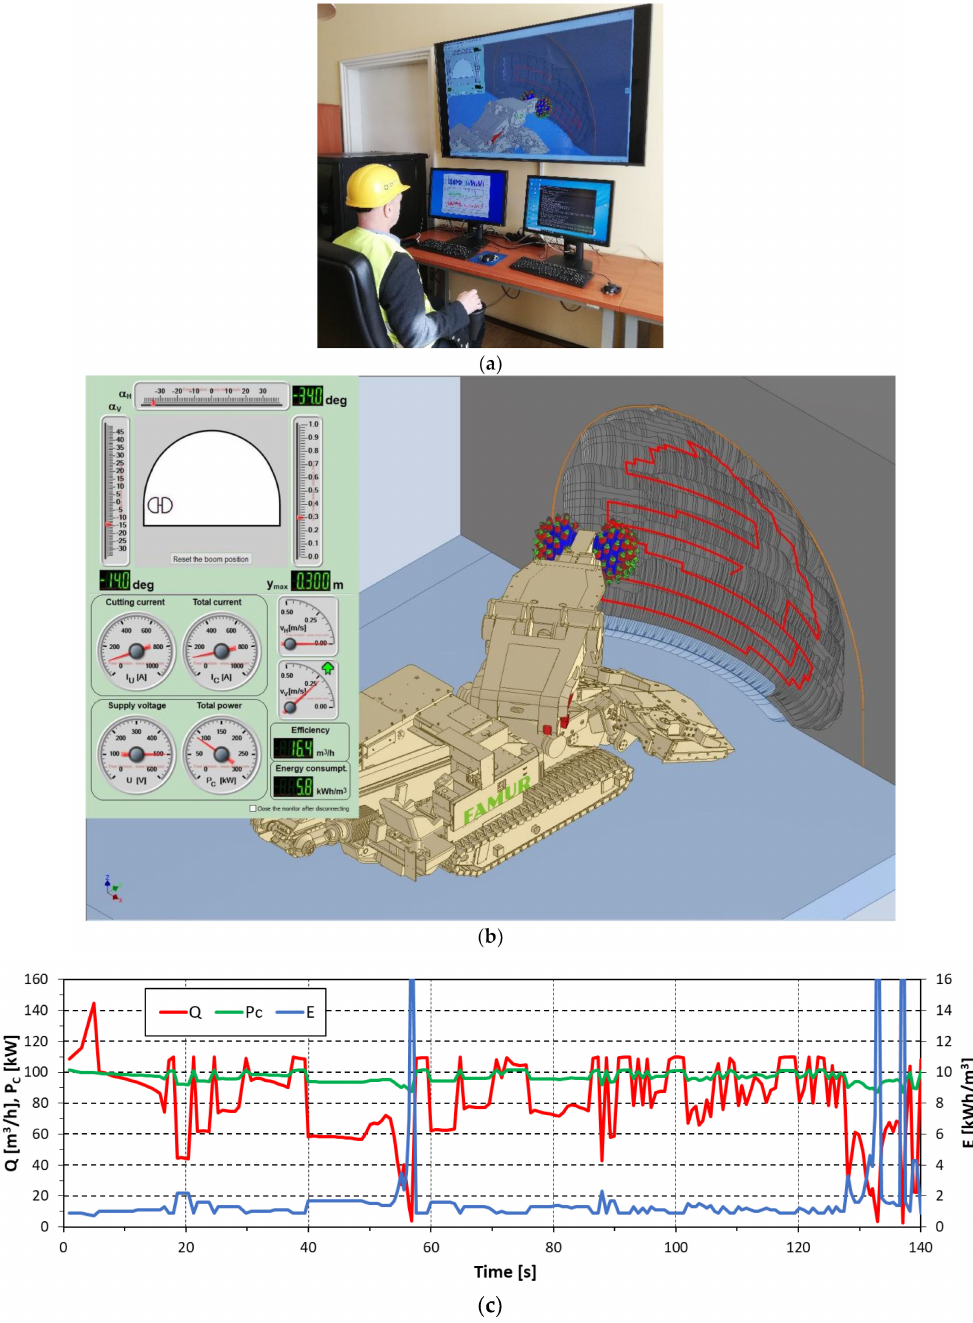
Figure 15. RH-Sim _research simulator in the manual control mode: ( a ) Operator Station, ( b ) view of the Main Program window, ( c ) the course of efficiency, power, and energy consumption of